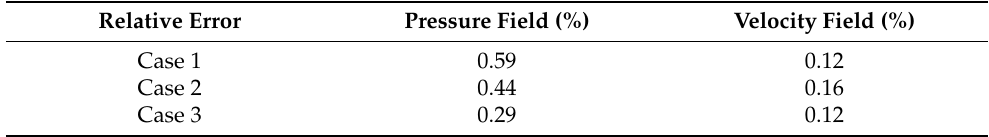
Table 7. Global error of eigenvalue of the CNN-DCNN model for cases in Figure